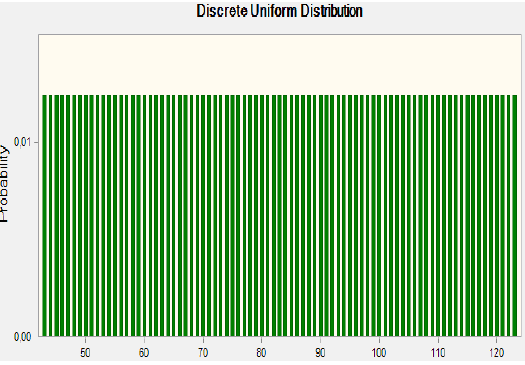
Figure 7. Probability distribution of rent prices of a standard double-room in the region of Liptov. Table 7. Descriptive statistics of the probability distribution for rent prices of a standard double-room in the region of Liptov.